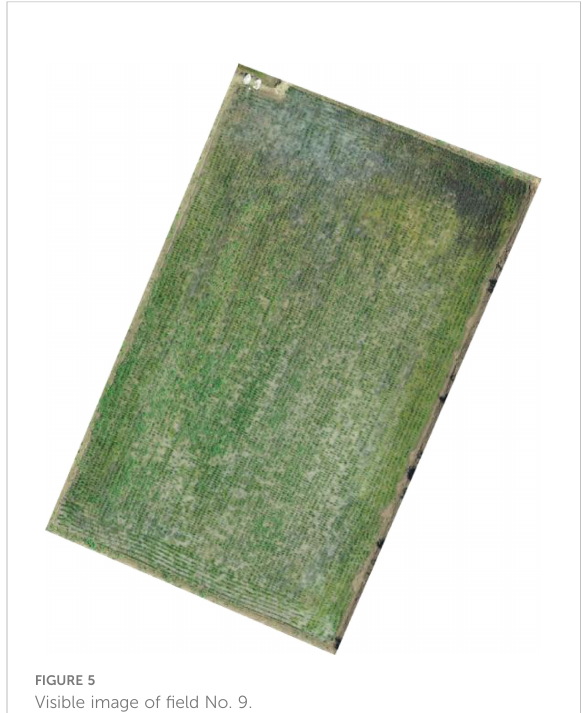
FIGURE 5 Visible image of fi eld No. 9.